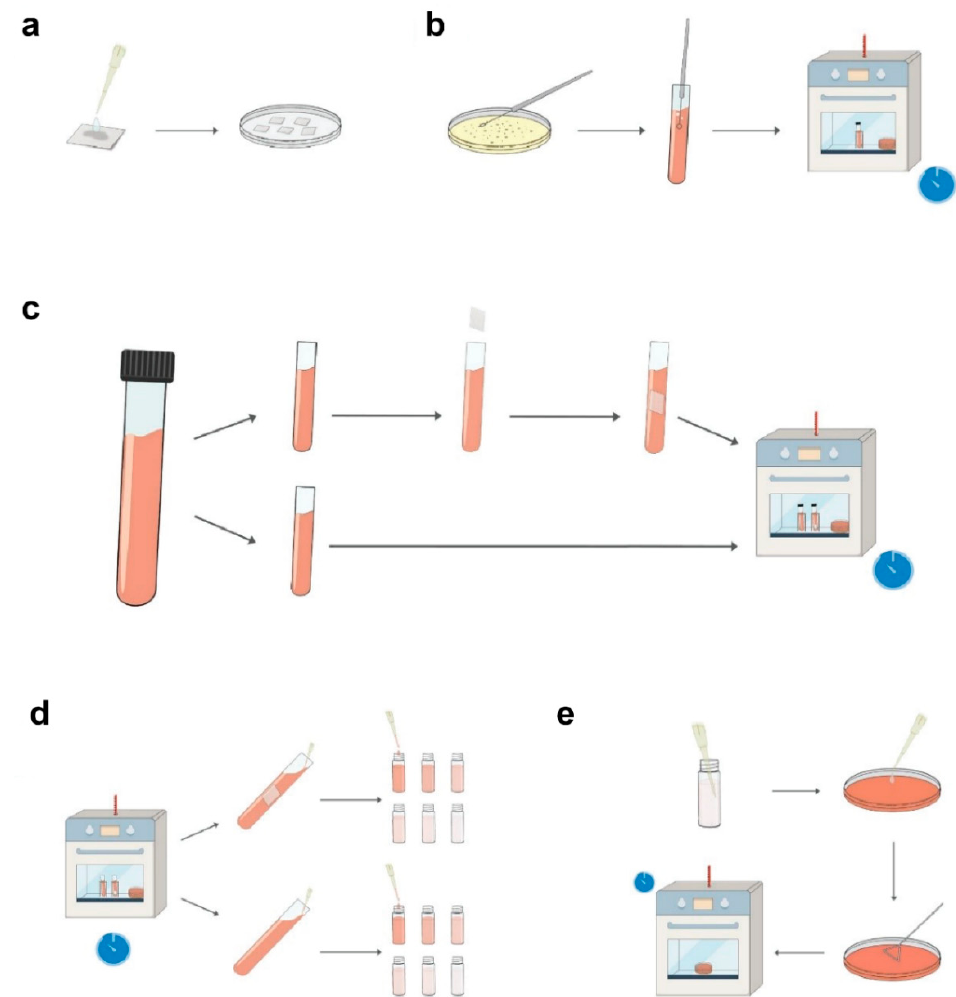
Figure 1. Test methodology of benzalkonium chloride (BKC) coated antibacterial paper. ( a ) Coating small paper sample with BKC solution, ( b ) transferring bacterial culture from nutrient agar plate to nutrient broth solution, ( c ) immersion of coated paper into bacterial culture, ( d ) series dilution for transferring the bacterial culture from nutrient broth media to nutrient agar plates, ( e ) transferring the dilute bacteria culture in nutrient broth to agar plates for titer